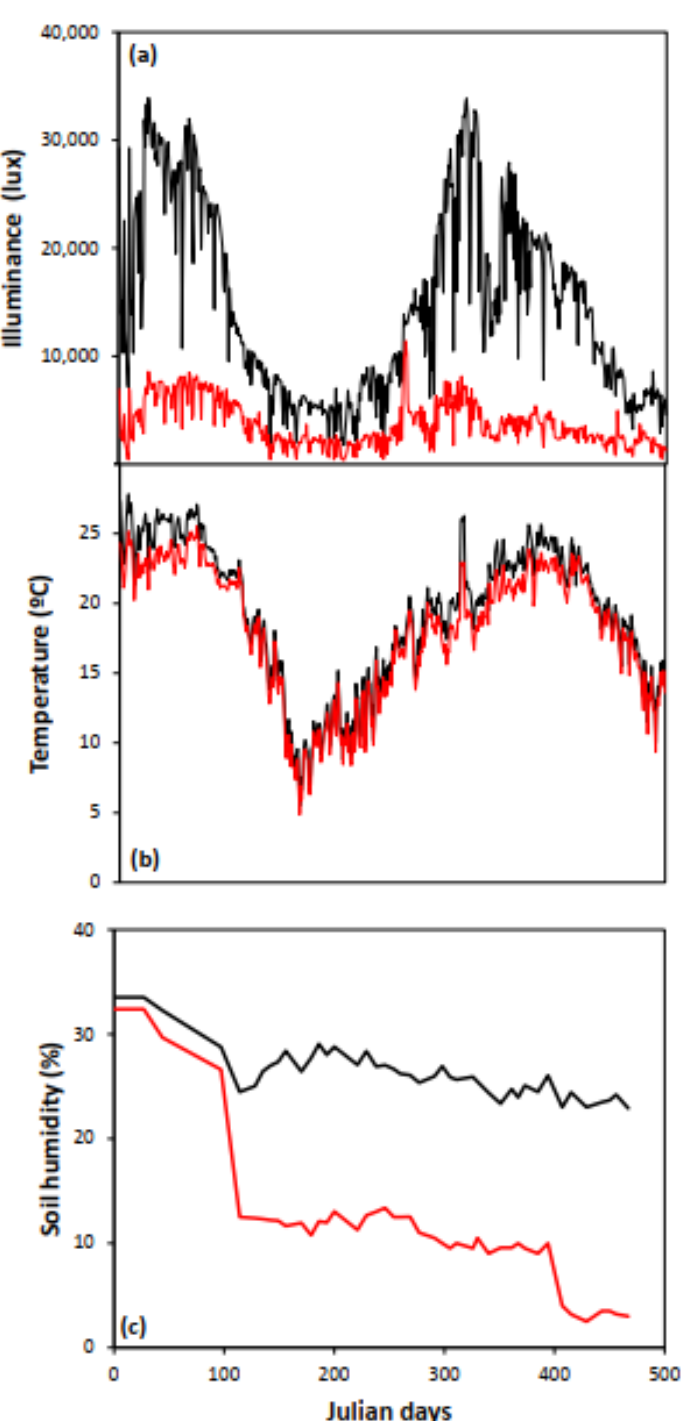
Figure 1. Environmental conditions in the greenhouse during the 467 days experimental period (starting in June). Light ( a ) and temperature ( b ) are shown for L+ (black line) and L − (red line) environments; while soil humidity ( c ) is shown for W+ (black line) and W − (red line) environments. The period when light and temperature decrease correspond to wintertime.